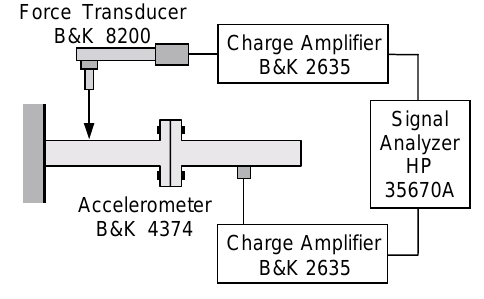
Fig. 6. Schematic of the experimental